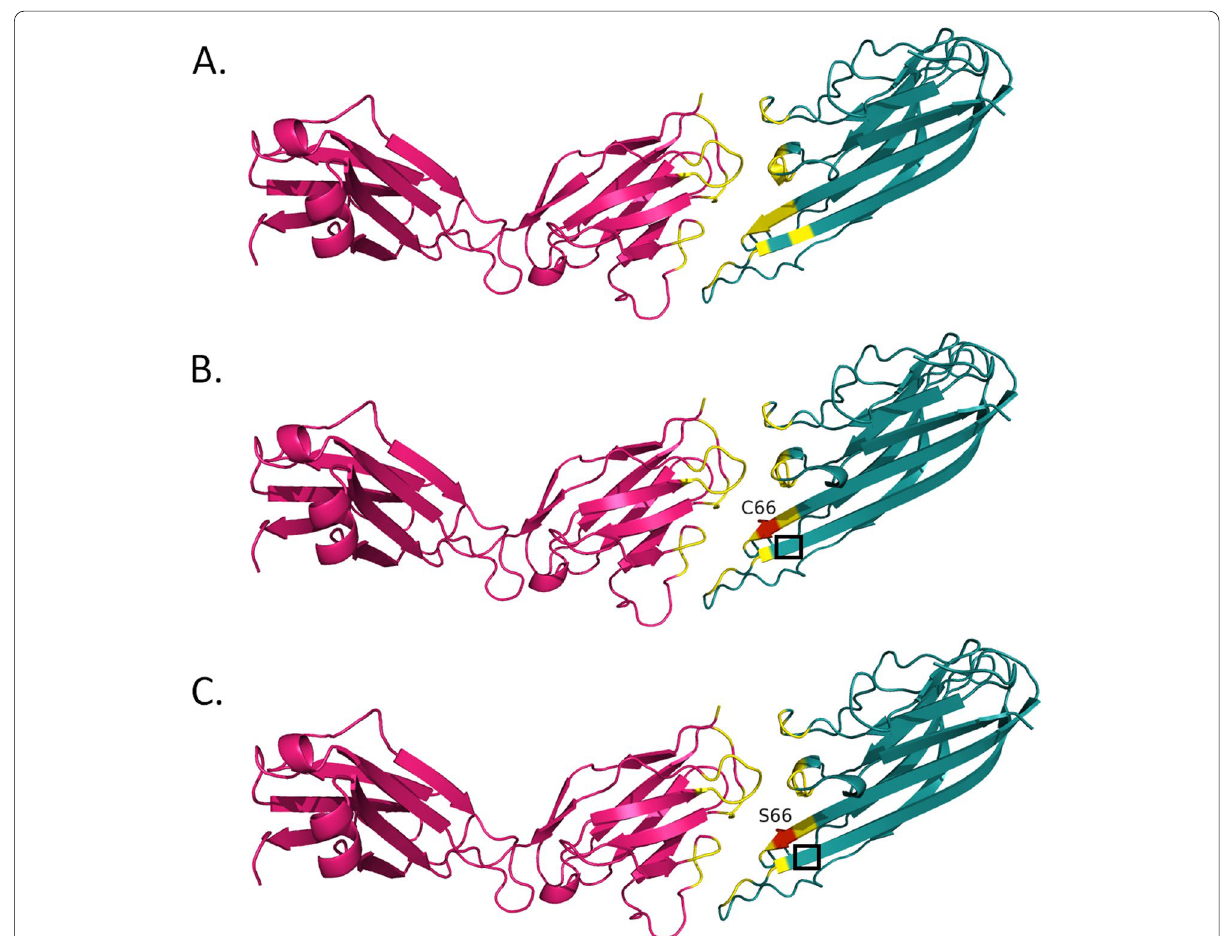
Fig. 2 Interactions between TNFA and adalimumab. Interactions between the light chain of adalimumab and TNFA WT ( A ), TNFA G66C ( B ), and TNFA G66S ( C ) structures. Hot pink- adalimumab light chain; deep teal- TNFA; yellow- interface; red- mutated residue. Regions with altered antigen-antibody interactions are denoted with black